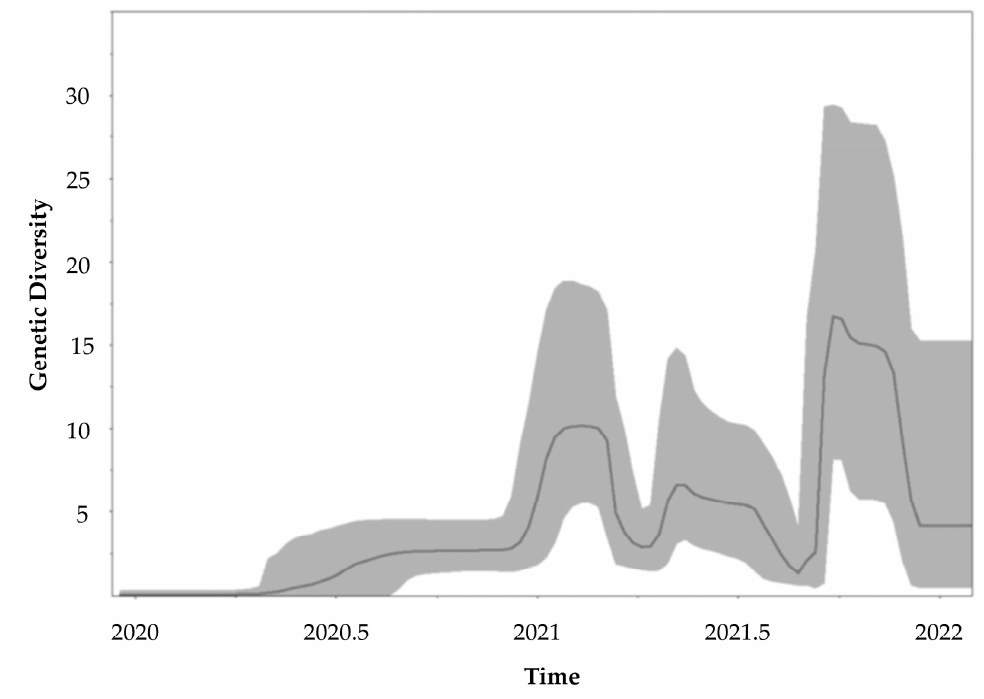
Figure 4. Molecular tracing of SARS-CoV-2 in the Dominican Republic. The evolution rate was evaluated by using the Bayesian Markov chain Monte Carlo (MCMC) approach implemented in BEAST (v1.10.4). Tracer software v 1.7.1 was used to produce the demographic reconstruction. The Y-axis represents the relative genetic diversity estimated using the effective number of infections through time on the X-axis. The solid line represents the median value, and the gray area represents the 95% credibility intervals.